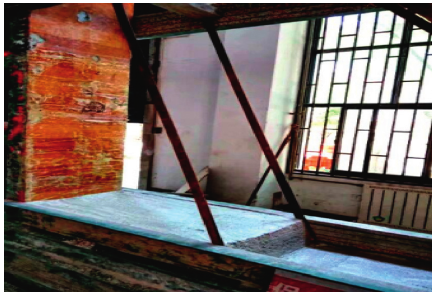
Figure 2: Layout of the steel strip. Figure 3: Layout of the test